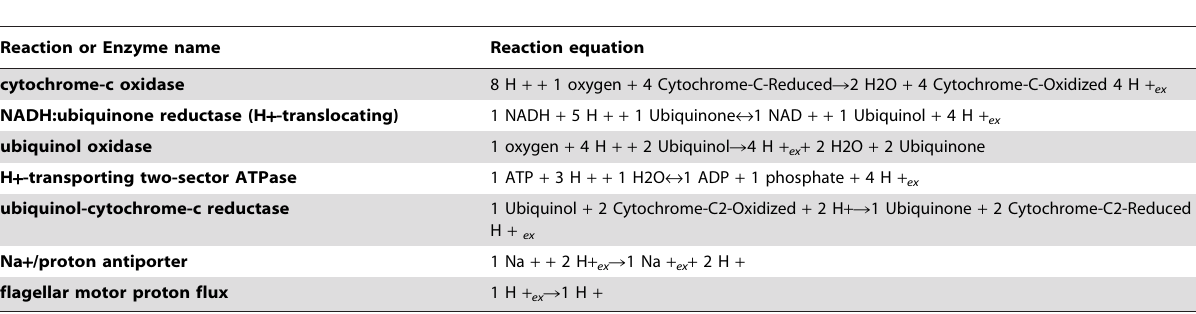
Table 3. Proton-translocating reactions in i